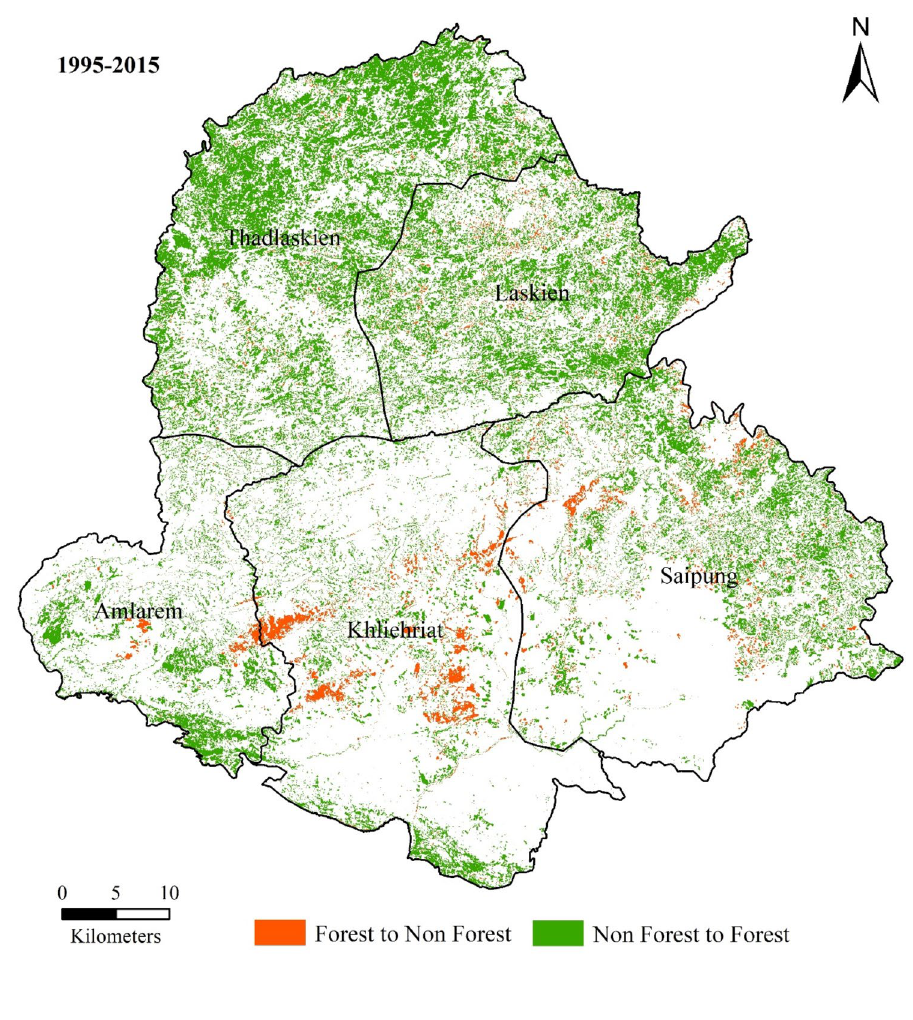
Land cover categories 1995 ----------------> Non-forest Dense forest Open forest Scrub forest 2015